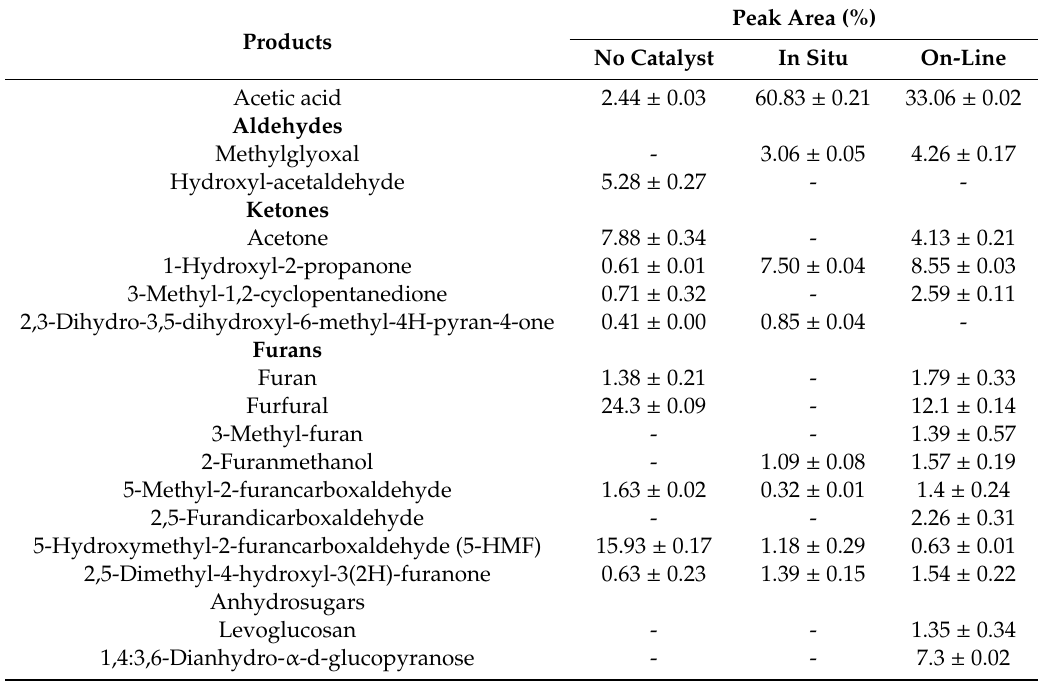
Table 2. Peak area % of the typical glucose pyrolysis products formed at 350 °C with (in situ and on-line) and without KAc.